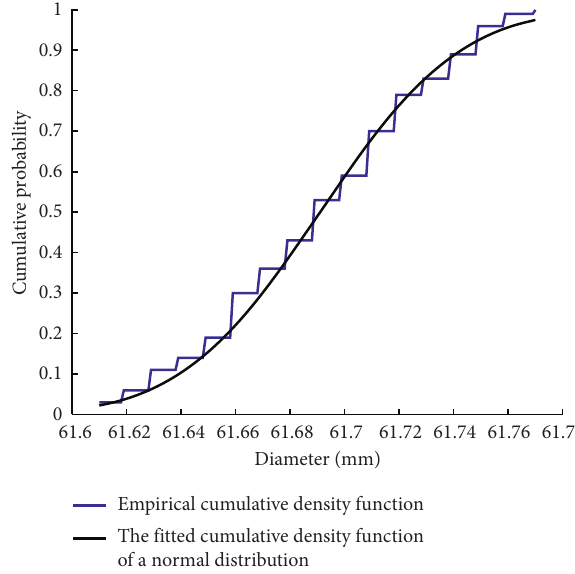
Figure 4: The cumulative distribution curve of the specimen diameter.